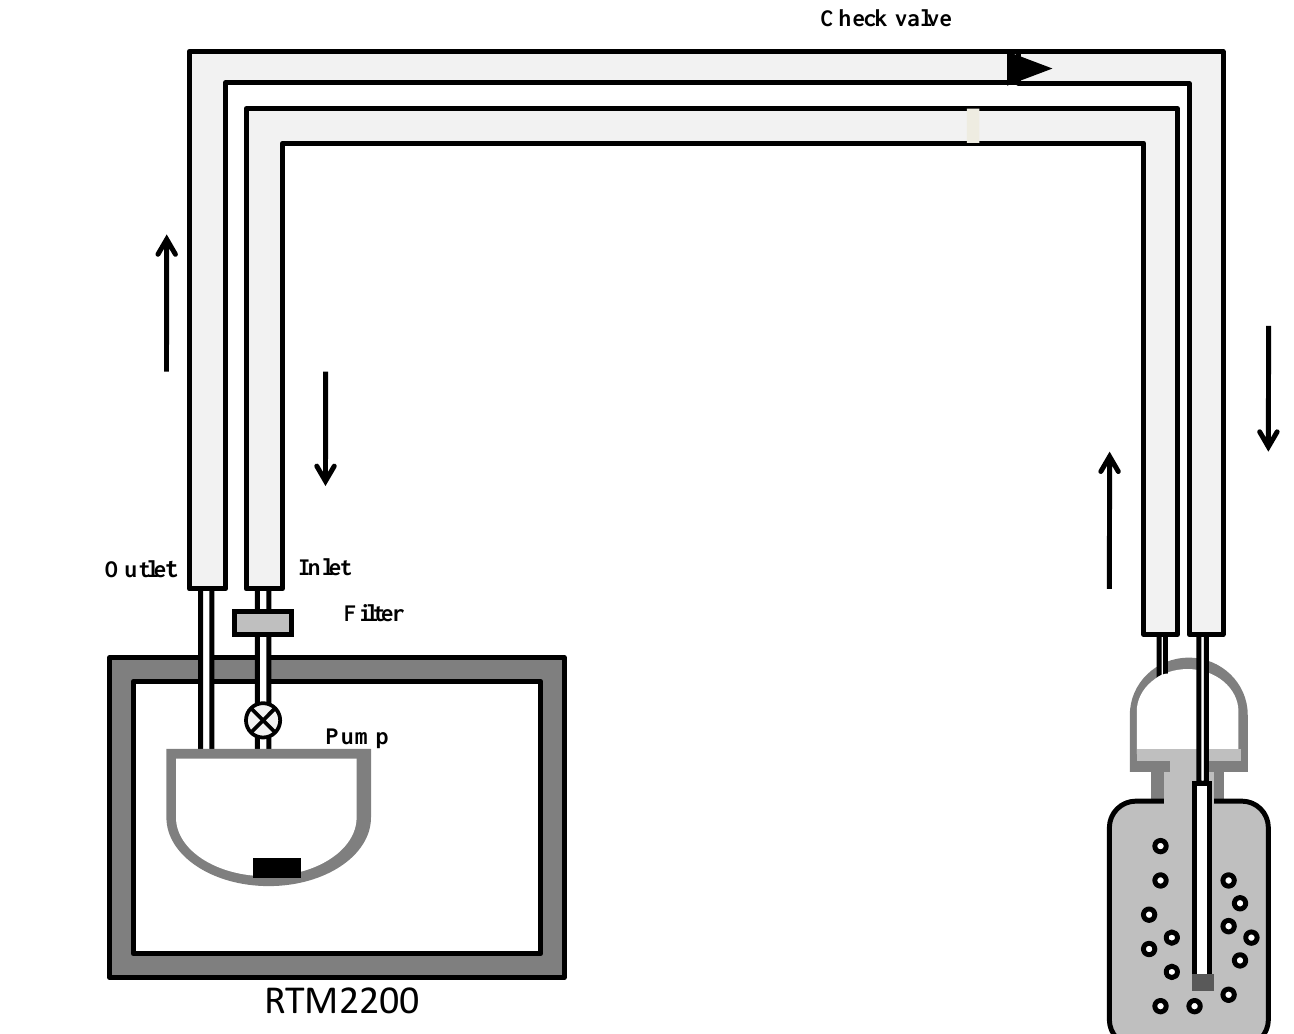
Figure 2. The set-up for radon measurements in water